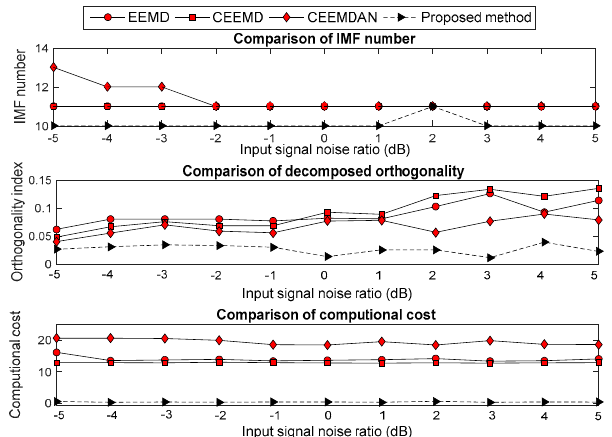
Figure 7. Comparison of the decomposition effect for the ‘blocks’ signal.